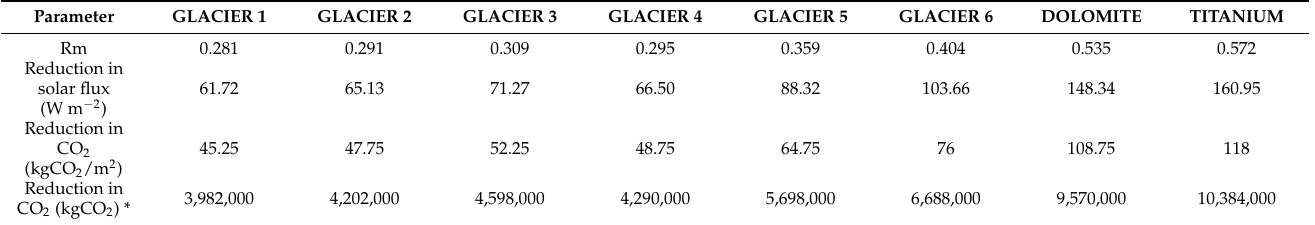
Table 4. Reduction in carbon dioxide emissions by using the tested concrete pavements with different albedo values (R m ) calculated taking as a reference the asphalt pavements